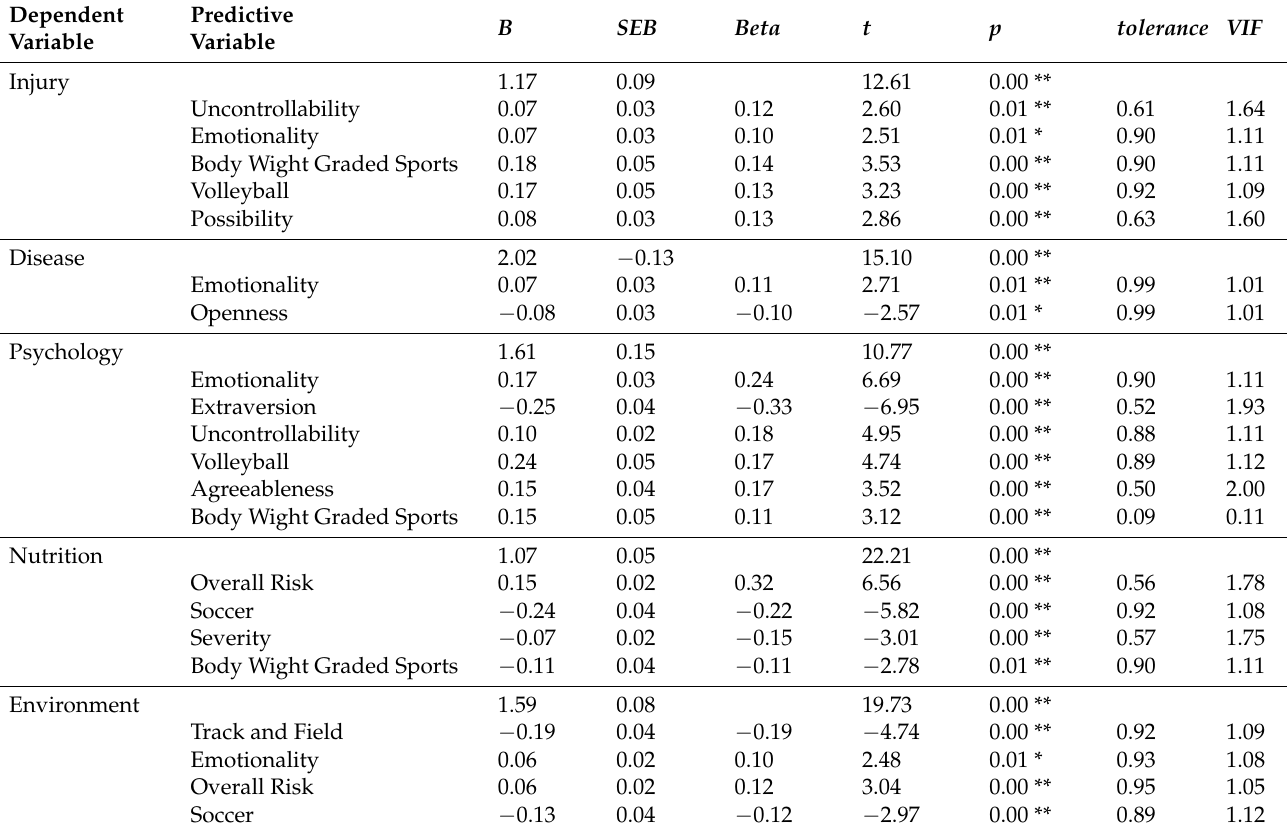
Table 6. Multiple regression results of prediction of various risk events ( n =